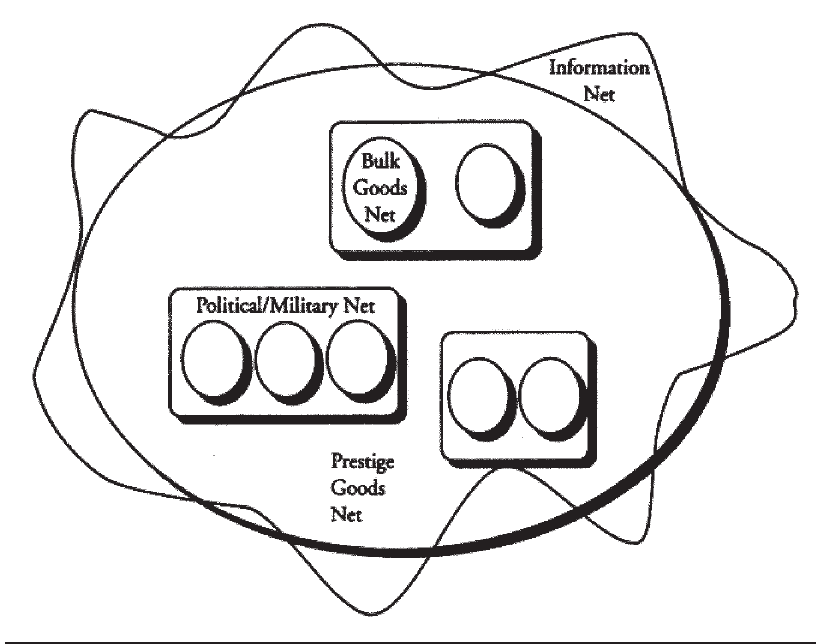
Figure 4 – Spatial Boundaries of